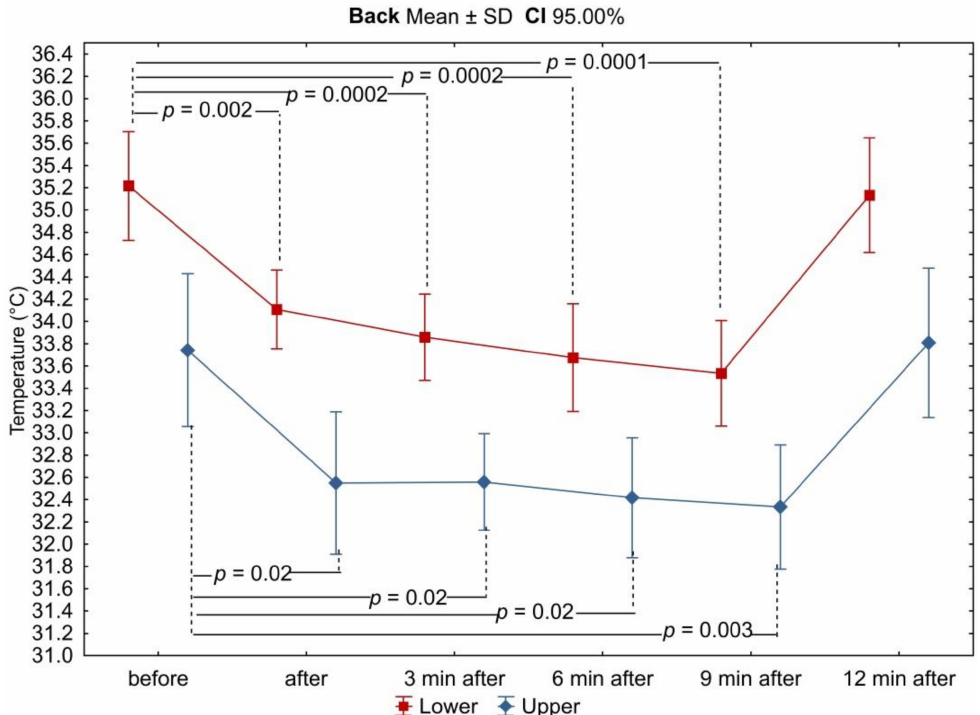
Figure 6. Differences in mean temperature values between the anterior and posterior surfaces of the forearms during successive measurement points before and after the exercise test. Legend: test probability level determination for Tukey’s RIR post hoc tests. Data are expressed as mean with standard deviation.